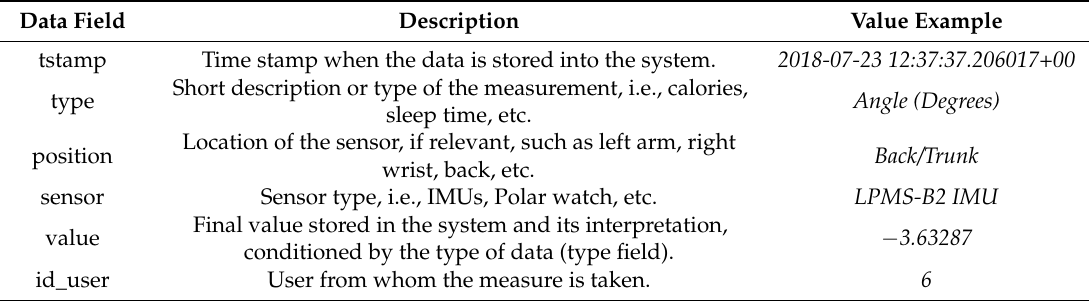
Table 2. Data Structure of a Sensory Measurement.